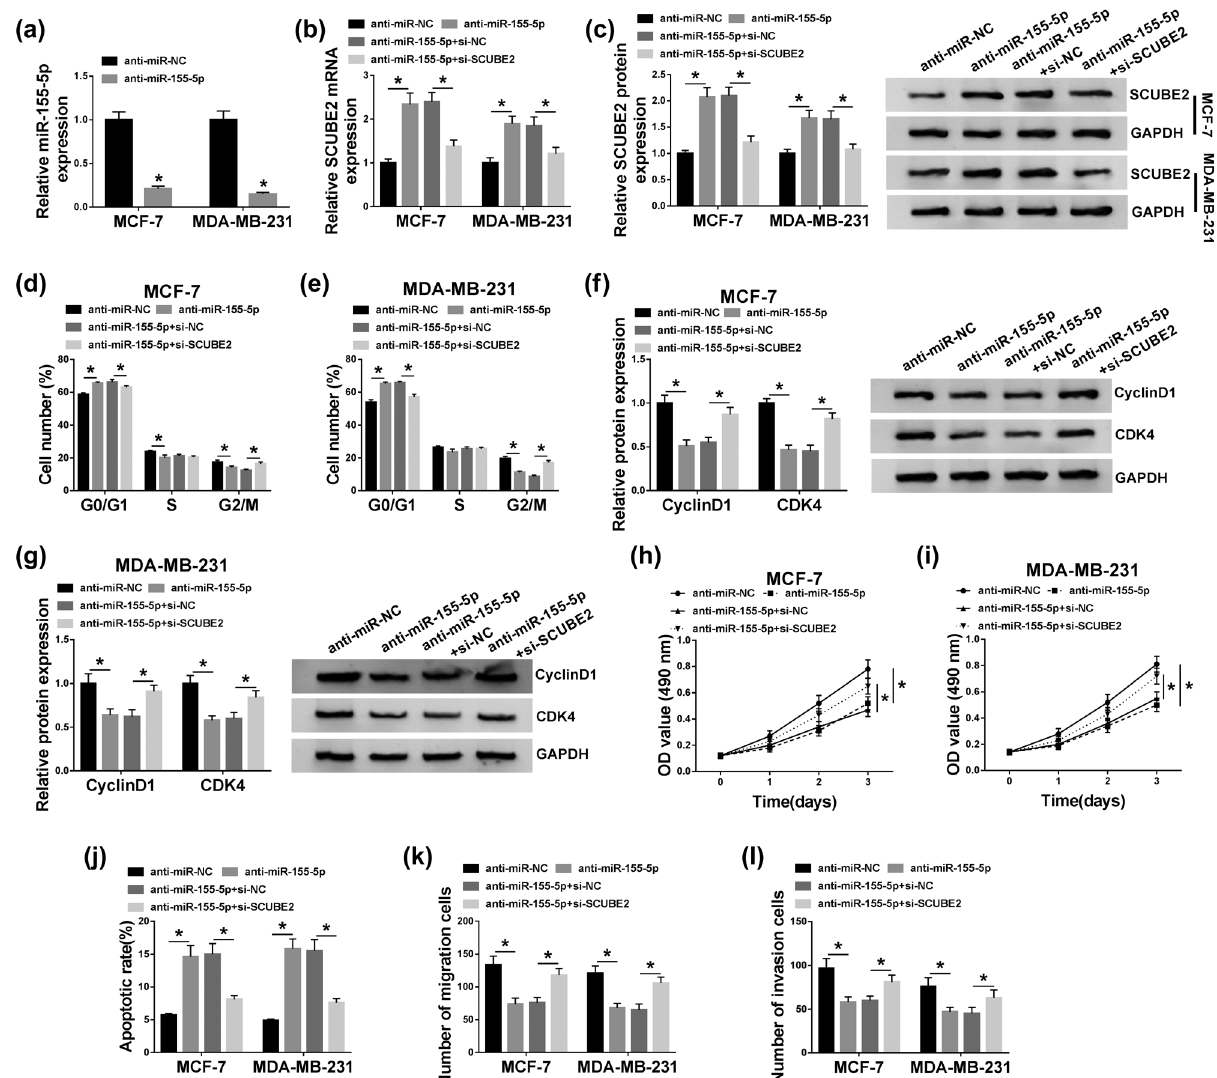
Figure 6: miR - 155 - 5pplayeditsroleinBCcellsviaSCUBE2. ( a ) Theexpression ofmiR - 155 - 5pinMCF - 7andMDA - MB -